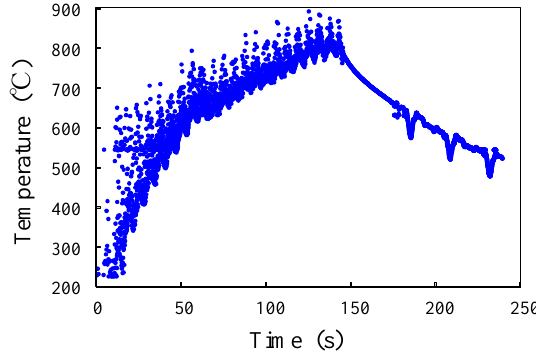
Figure 1. Infrared (IR) camera temperature data for sample 151014. Table 1. Sample number and maximum coating